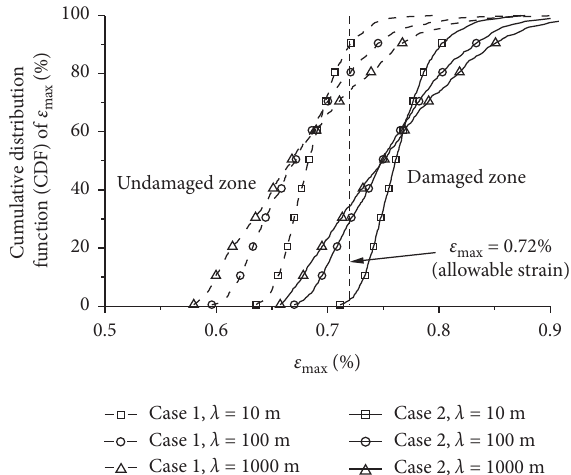
Figure 12: Relationship between correlation length and statistics of the maximum cable strain ε of ε max .